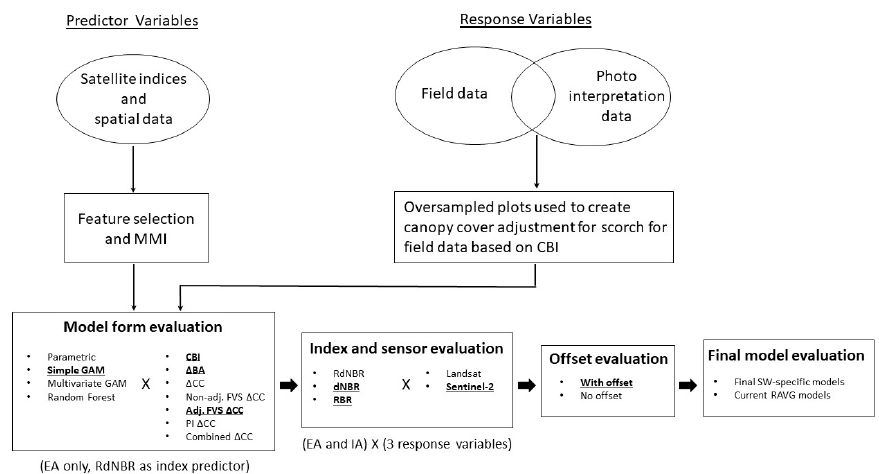
Figure 3. A flowchart of the analysis process. Circles indicate datasets and squares indicate analysis processes. Thin arrows depict where specific processed data are used; see Methods Section and Appendix A for complete description of all data used. Bold arrows indicate model evaluation steps taken in sequence. Variables and model form in bold and underlined were those carried forward into successive model development steps.